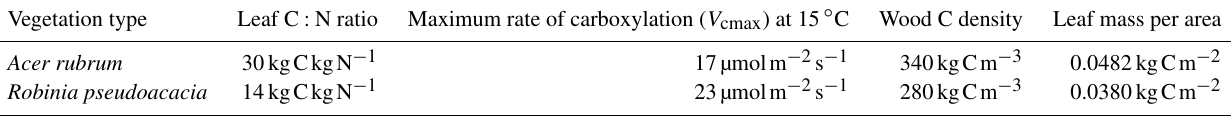
Table 1. Key parameter differences between vegetation types. See Table D1 for remaining vegetation-type-specific parameters. Vegetation